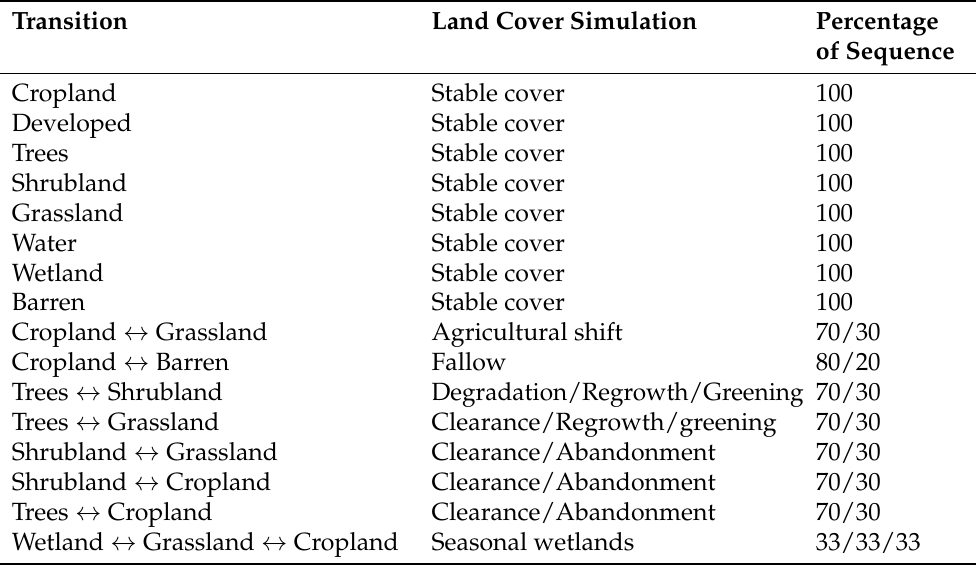
Table 3. Land cover transitions used in the temporal augmentation of pseudo time series sequences. The first column describes the land cover transitions. Single land covers represent stable sequences. The ↔ symbol indicates the sequence was generated in both directions. The second column describes the land cover change that the sequence is intended to represent. The third column shows the percentage breakdown of the land covers in the sequence. As an example, the trees-to-cropland sequence represents clearance for agriculture when sorted by trees → cropland, and cropland abandonment and regrowth when sorted by cropland → trees. In the trees → cropland sequence, the first 70% of the sequence is trees (i.e., 17 years) followed by 30% (3 years) of cropland samples, and vice versa for cropland →